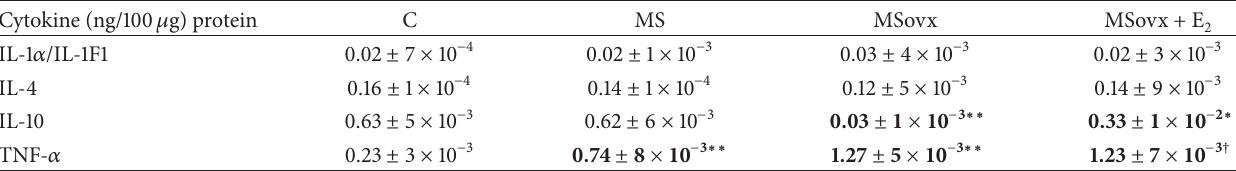
Data are means ± SE; 𝑛 = 7 for each group. Statistically significant at MSovx versus MSovx + E 2 ∗ 𝑝 < 0.01 , ∗∗ C and MSovx versus MS 𝑝 < 0.001 , and †